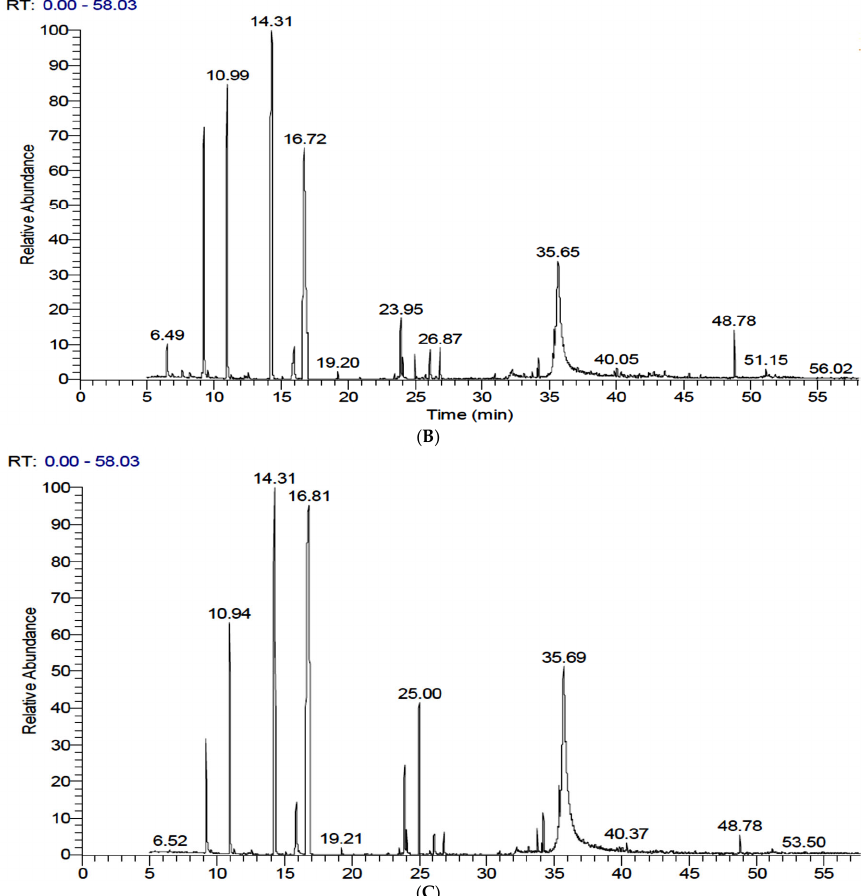
Figure 2. GC ‐ MS chromatograms of fennel seeds and their sprouts after 15 days of sprouting at 17 ± 1 °C and 90–93% RH. ( A ): Raw fennel seeds, ( B ): 6 ‐ day sprouts, and ( C ): 9 ‐ day sprouts.